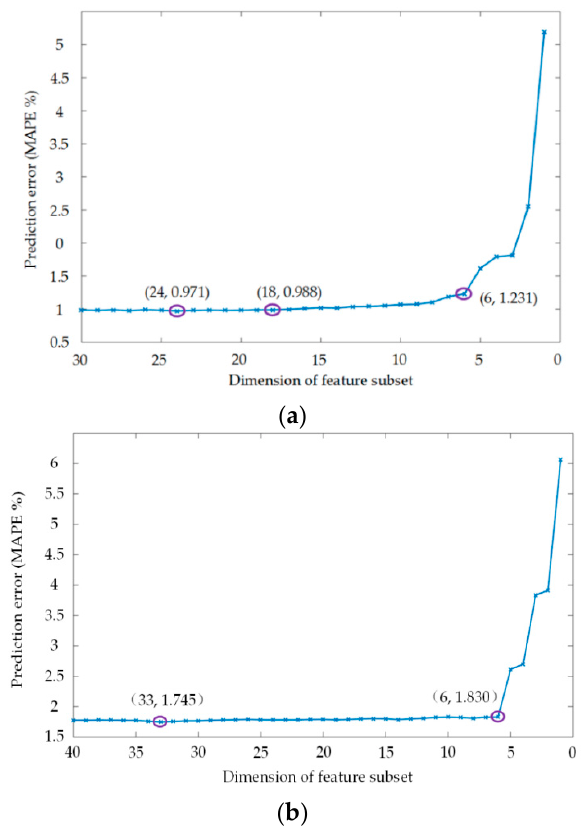
Figure 6. ( a ) Prediction error (MAPE) of different feature subsets obtained from SBS method of 1 ‐ h ‐ ahead prediction; ( b ) prediction error (MAPE) of different feature subsets obtained from SBS method of day ‐ ahead prediction.